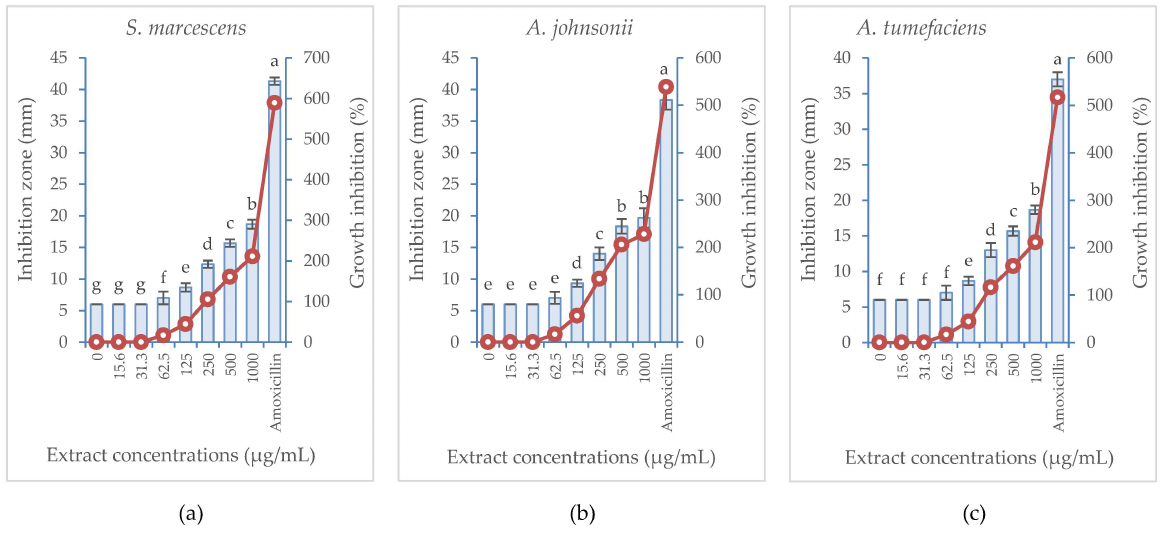
Figure 2. Inhibition zone (vertical bars on primary axis) and growth inhibition percentage (line on secondary axis) of three bacterial species in response to the treatment with B. aegyptiaca methano- lic fruit extract at various concentrations compared with amoxicillin at 62.5 µ g/mL: ( a ) Seratia marcescens , ( b ) Acinetobacter johnsonii , ( c ) Agrobacterium tumefaciens . Values are represented as the mean (n = 4) ± SD indicated by the vertical bars.